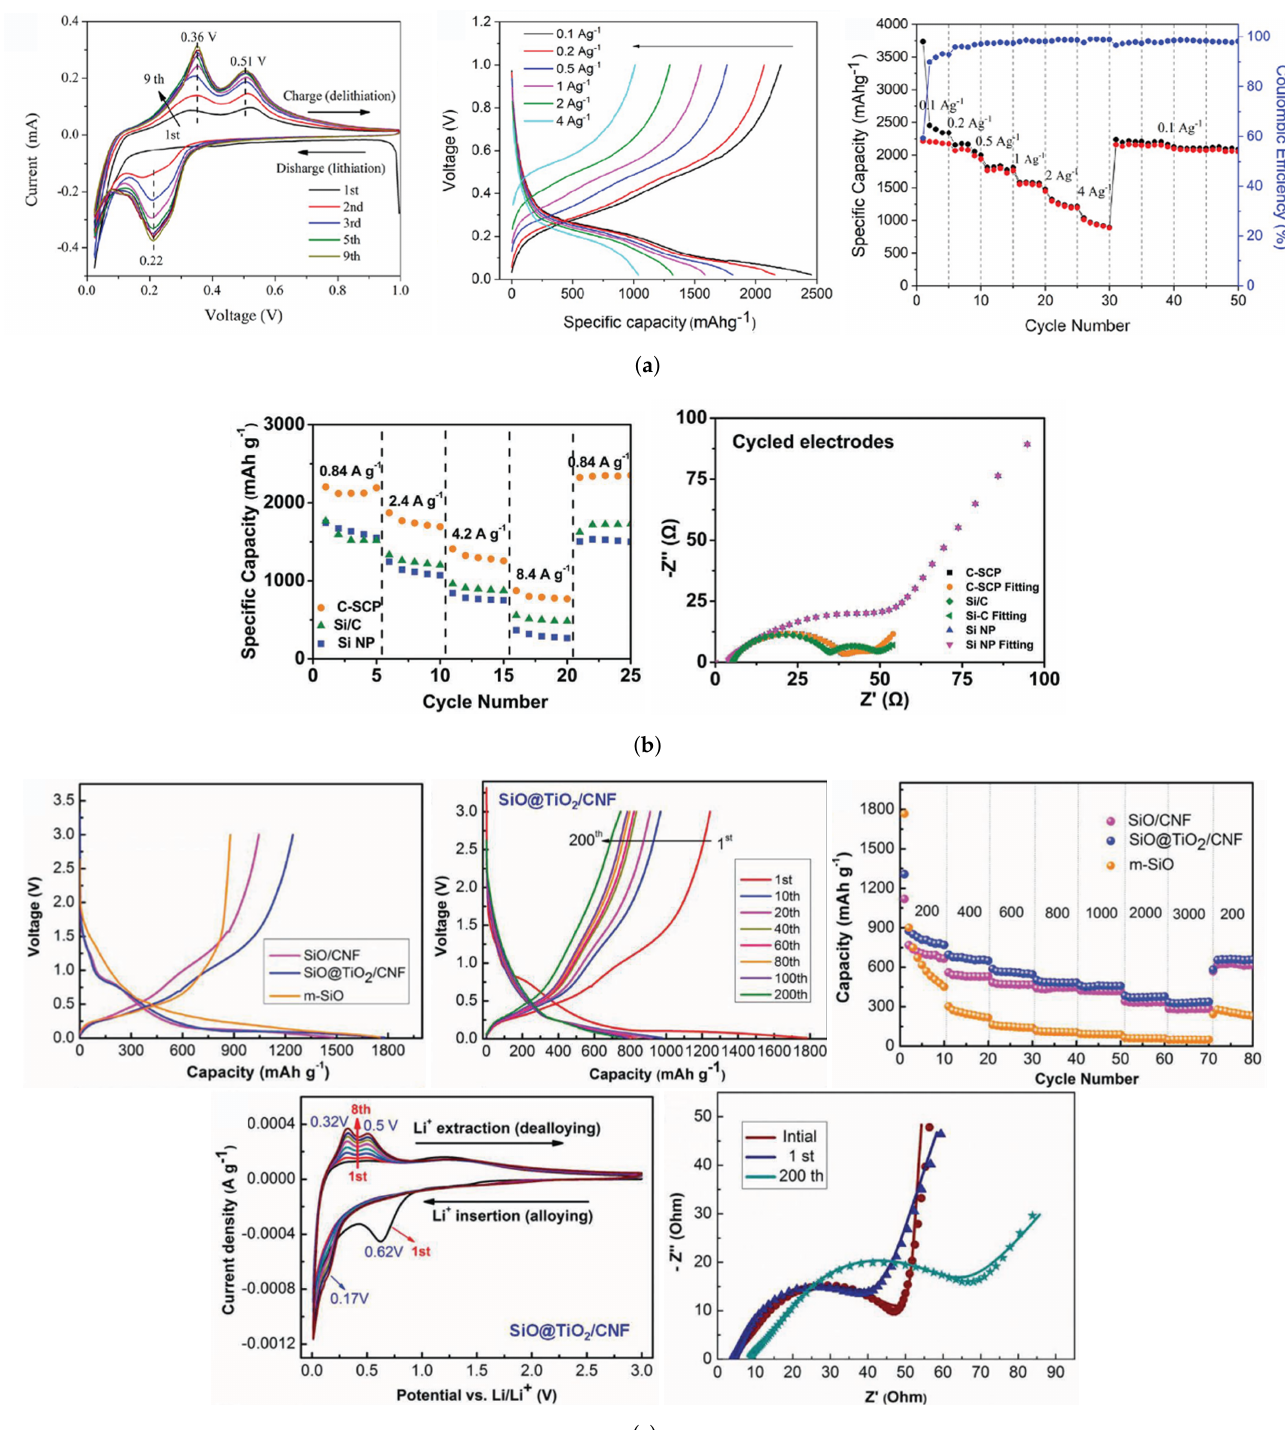
Figure 20. Composite Si/M anodes (M - metal) obtained with a M protective shell and a Si core. All figures reused with permission. ( a ) Charge/discharge curves, rate capability, and cyclic voltammetry for a Si@C-Cu anode. Reproduced with permission [111]. ( b ) Rate capability and Nyquist plots comparison between Si NP, Si@Cu (Si/C), and Si@C-Cu (C-SCP) anodes. Reproduced with permission [108]. ( c ) Charge/discharge curves comparison between SiO@TiO 2 /carbon nanofiber (SiO@TiO 2 /CNF), SiO/CNF, and ball milled SiO (m-SiO), and cyclic voltammetry curves and Nyquist plots for SiO@TiO 2 /CNF. Reproduced with permission